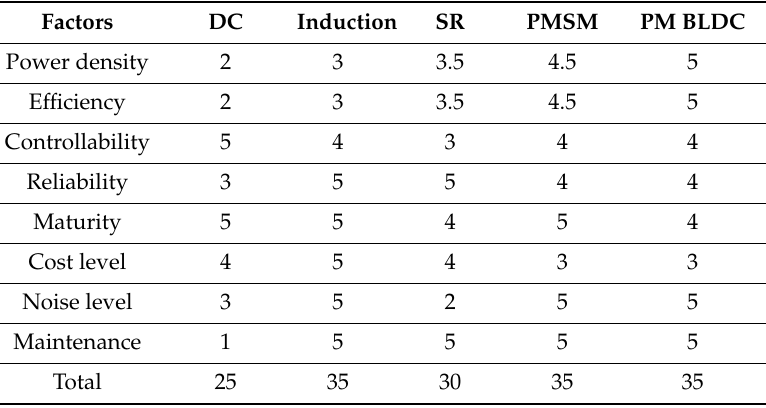
Table 1. Evaluation of existing EV drives.